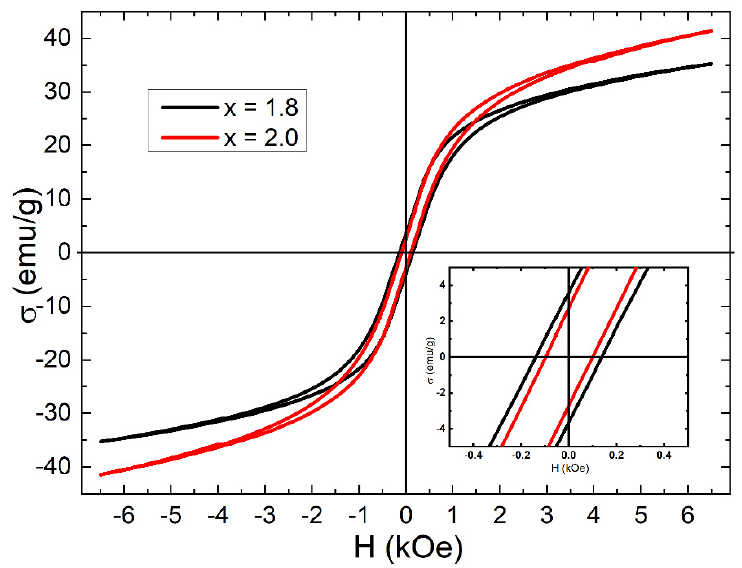
Figure 4. Hysteresis loops of hexaferrites Ni 2-x Cu x -Y system with x = 1.8, 2.0 at room temperature. 3.4. Study of Composite Samples of NiCu-Y Hexaferrite in the Microwave Frequency